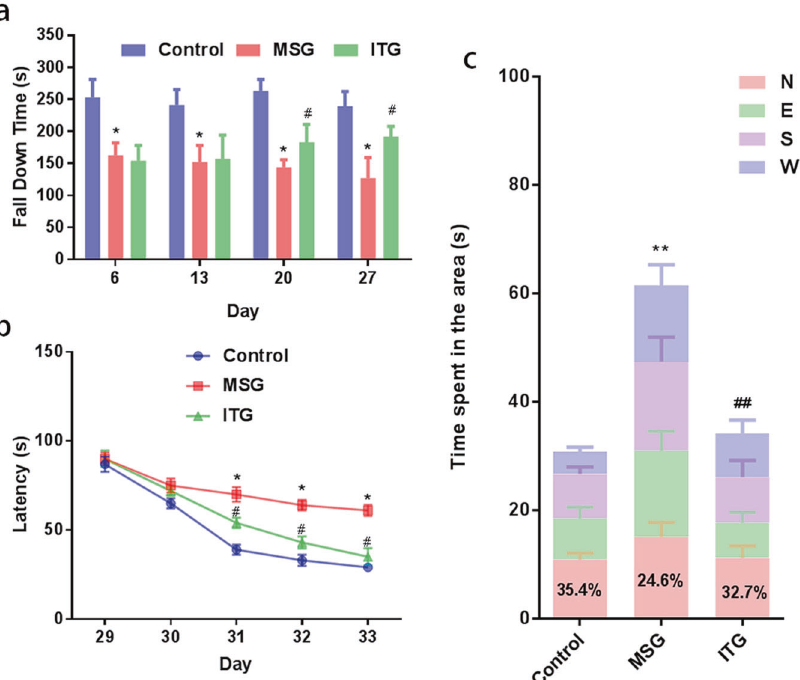
Fig. 2 Effects of idebenone on motor and learning and memory impairment. a Rotarod test. Effect of idebenone treatment on motor dysfunction in PD model mice. b Water maze test. Effect of idebenone treatment on learning and memory ability of PD model mice (second phase). c Water maze test. Effect of idebenone treatment on learning and memory ability of PD model mice (third phase). * P < 0.05, ** P < 0.01 vs. control, # P < 0.05, ## P < 0.01 vs. MSG, N = 5.